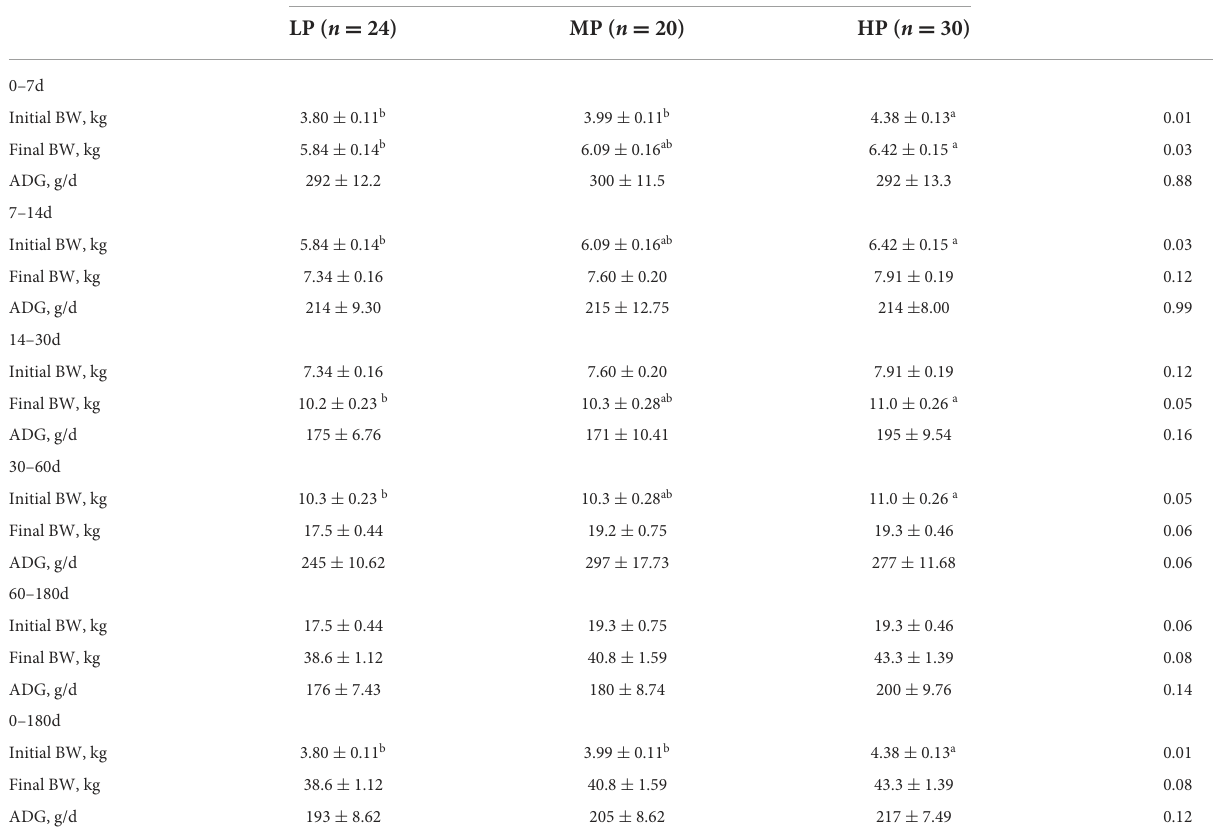
TABLE 3 Effects of three different dietary protein levels on growth performance of twin lambs.